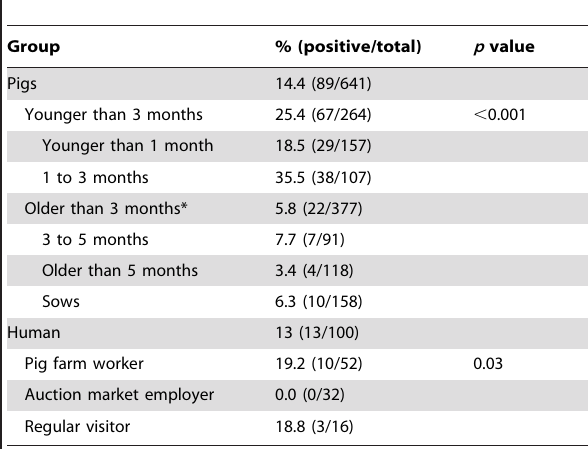
Table 1. Methicillin-resistant Staphylococcus aureus prevalence among different groups of pigs and humans in